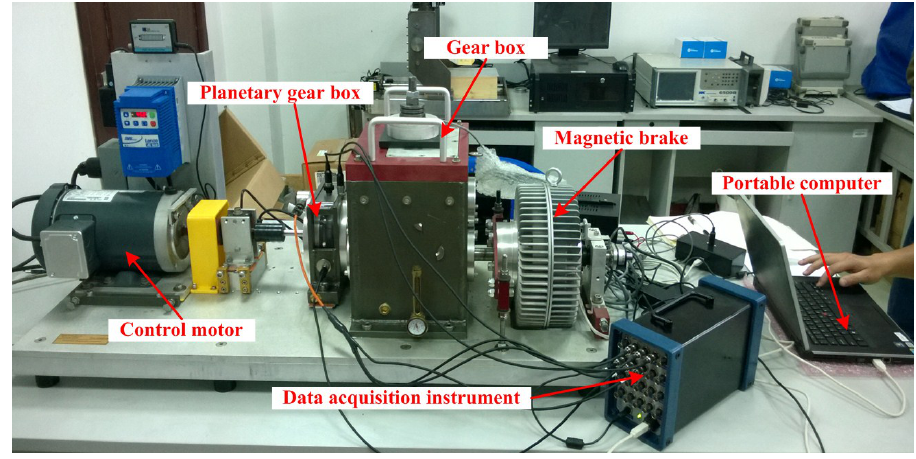
Figure 2. Drivetrain Dynamics Simulator (DDS) comprehensive test bed for fault diagnosis.